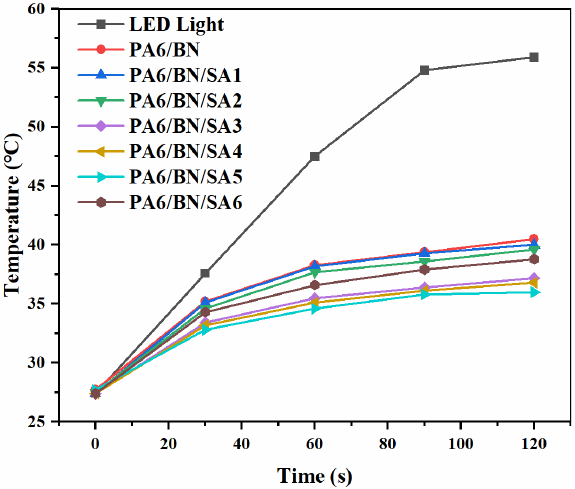
Figure 7. Temperature–time profiles of LED lamps.